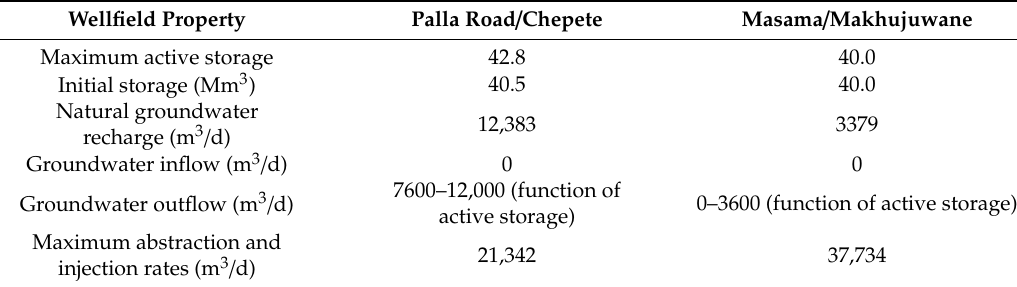
Table 2. Input data on Managed Aquifer Recharge (MAR) wellfields to the